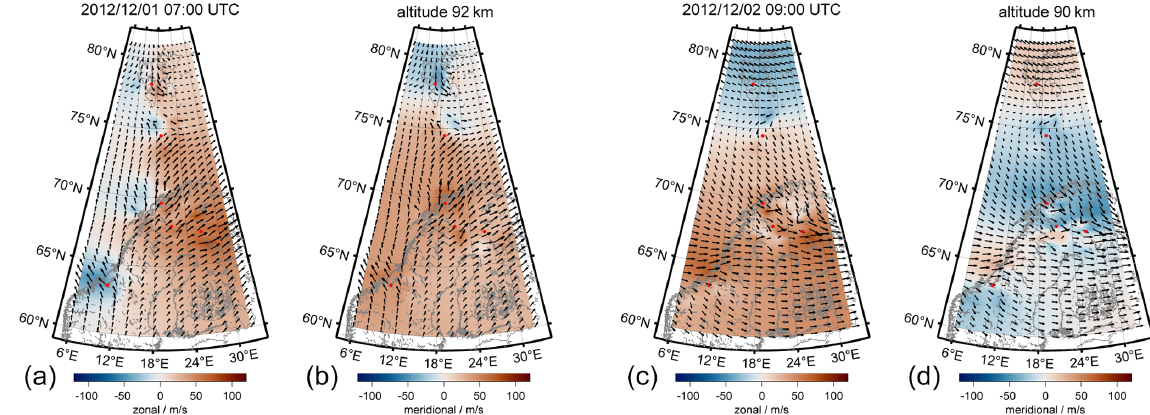
Figure 16. Meteorological wind maps obtained from the 3D-Var algorithm using a geographic grid and all MRs involved in ARISE.